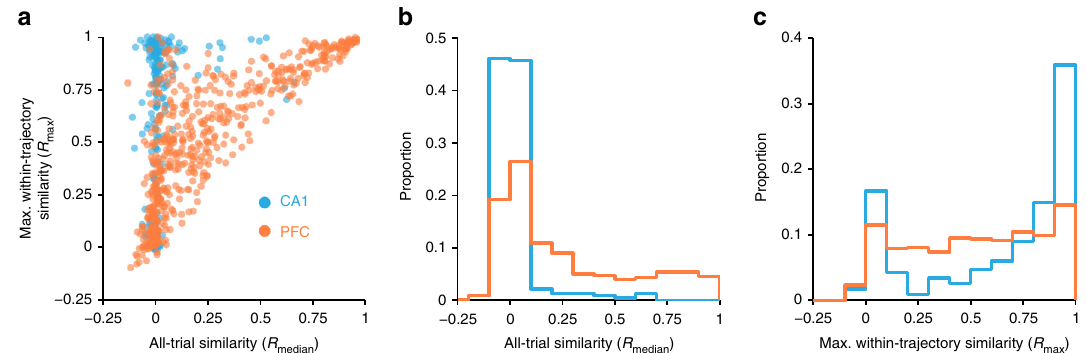
Fig. 2 Location speci fi c CA1 and diverse task PFC activity patterns. a Scatter of R max and R median for CA1 (cyan, N = 234) PFC cells (orange, N = 556). b Distribution of R median (from a ) for CA1 (cyan, N = 234) and PFC cells (orange, N = 578). Kolmogorov – Smirnov test: *** p < 10 − 4 . c Distribution of R max (from a ) for CA1 (cyan, N = 234) and PFC cells (orange, N = 556). Kolmogorov – Smirnov test: *** p < 10 −